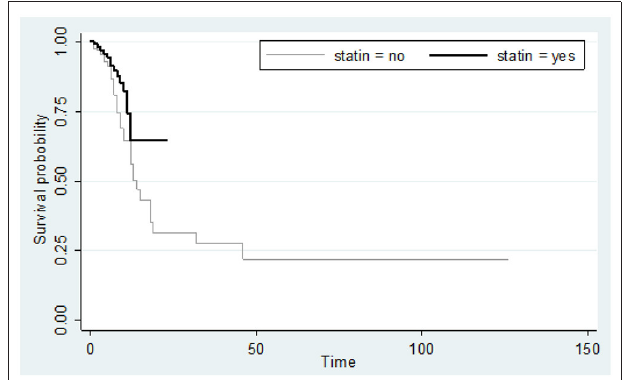
FIGURE 1 | Kaplan-Meier curve comparing the survival time (in days) between statin users and statin non-users considering mortality as an event. Value test log-rank = 4.46; p -value =